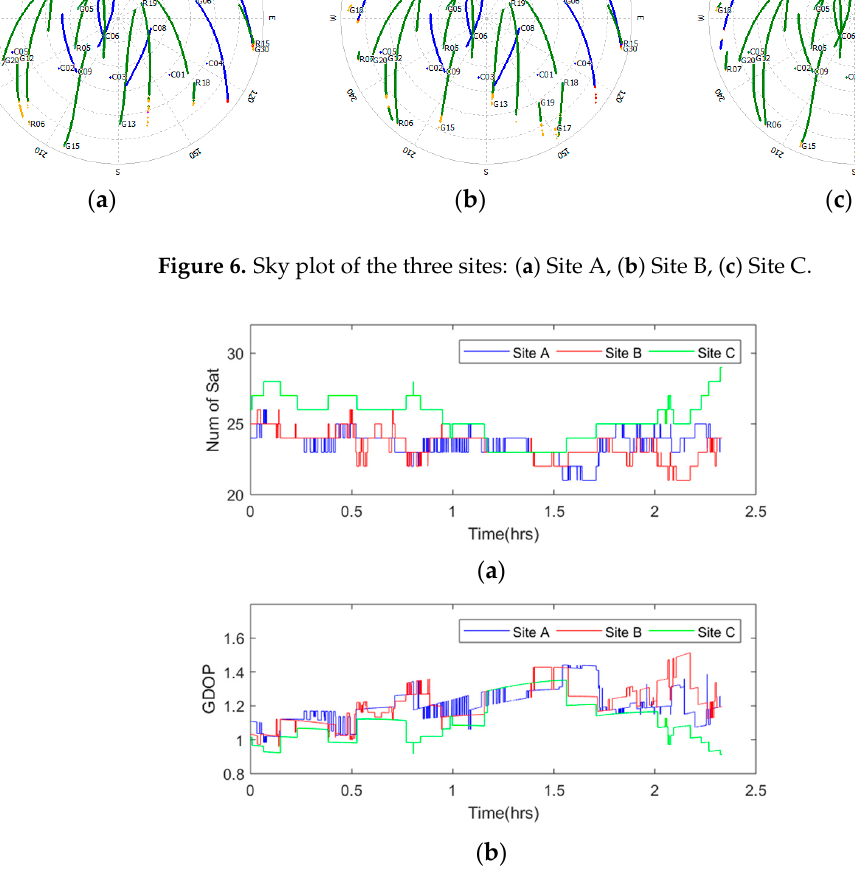
Figure 7. Number of visible satellites and GDOP values during the data collection. ( a ) Number of visible satellites, ( b ) GDOP values.